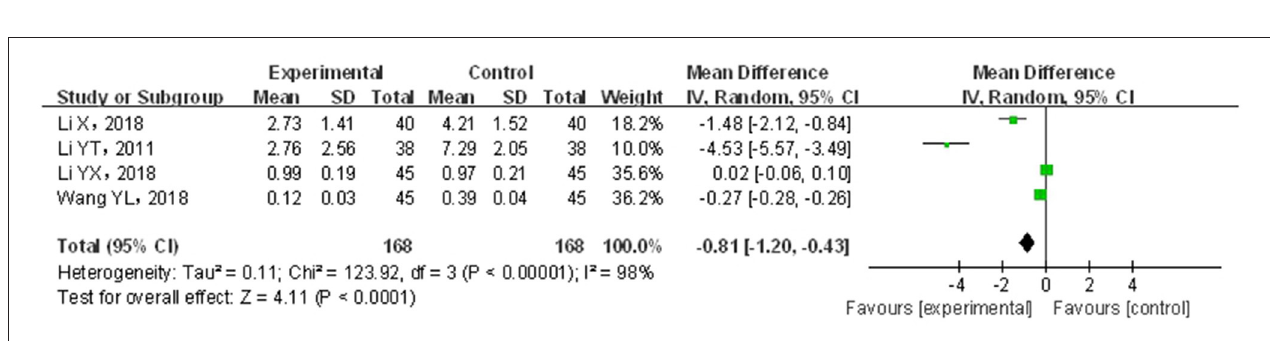
In our view, higher heterogeneity might be related to multiple included in each study, different manipulation techniques in for